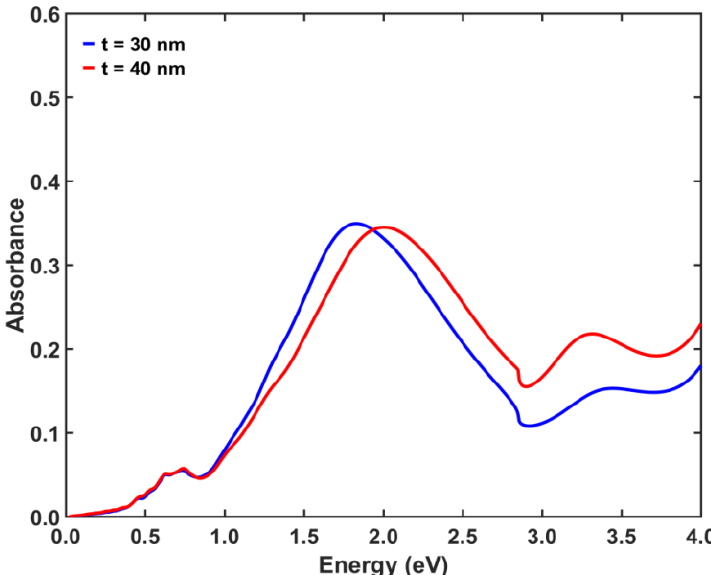
Figure 9. The absorbance spectrum of 85 at.%Ag and 15 at.%Pd, when d= 200 nm, a = 300 nm. The dependence of LSPRs was further evaluated in terms of thickness t, particularly examining the 85 at.% Ag and 15 at.% Pd alloy of d = 100 nm and a = 200 nm, along with t = 30 nm (blue curve of Figure 8), but decreasing the t value from 30 to 15 and 10 nm, respectively. It is obvious that the decrease in the t value causes the red shift of the resonance and a slight drop of the absorbance max value, respectively. Both graphs for either t = 10 nm or t = 15 nm reflect steeper curves compared to the curve of Figure 8 (blue graph), supporting the experimental results that the shape and position of LSPRs are straightforward to the thickness of AgPd NPs. Figure 10 illustrates the absorbance spectra with the reduced values of thickness. The blue graph depicts the absorbance spectrum when t = 10 nm, and the red graph depicts the spectrum when t = 15 nm.